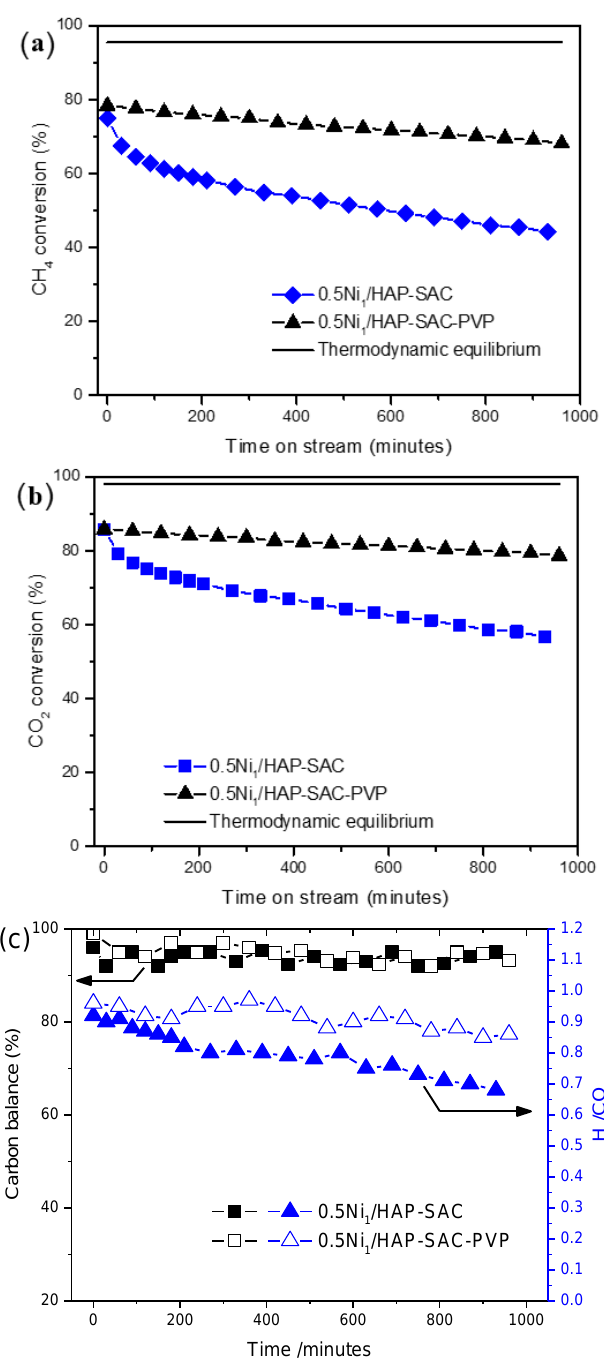
Figure 8. ( a ) CH 4 Conversion and ( b ) CO2 conversions over 0.5Ni 1 / HAP-SAC and 0.5Ni 1 / HAP-SAC-PVP stabilized PVP. ( c ) Carbon Balance and H 2 / CO ratio over 0.5Ni 1 / HAP-SAC and 0.5Ni 1 / HAP-SAC-PVP stabilized PVP.